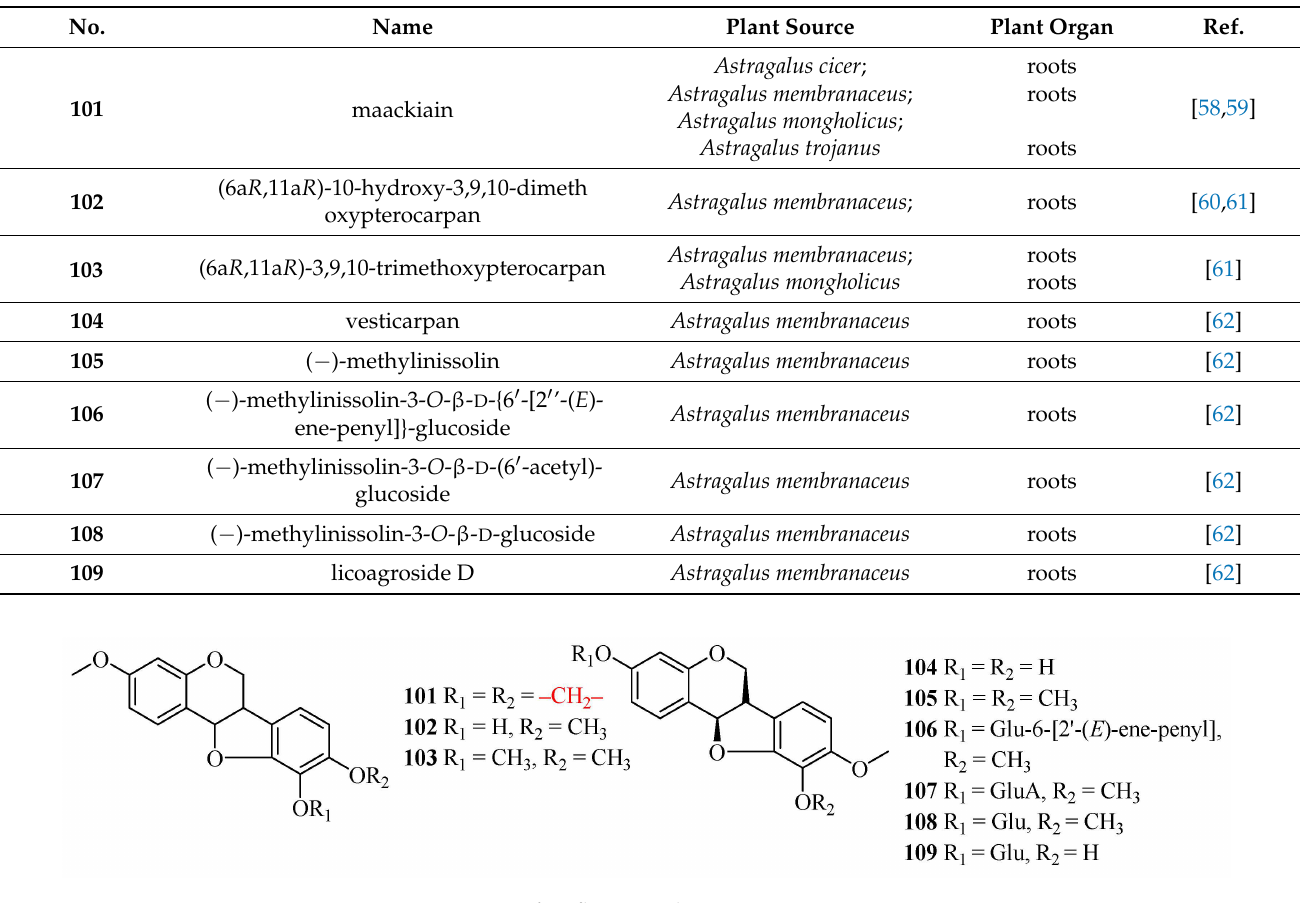
Figure 5. Structures of